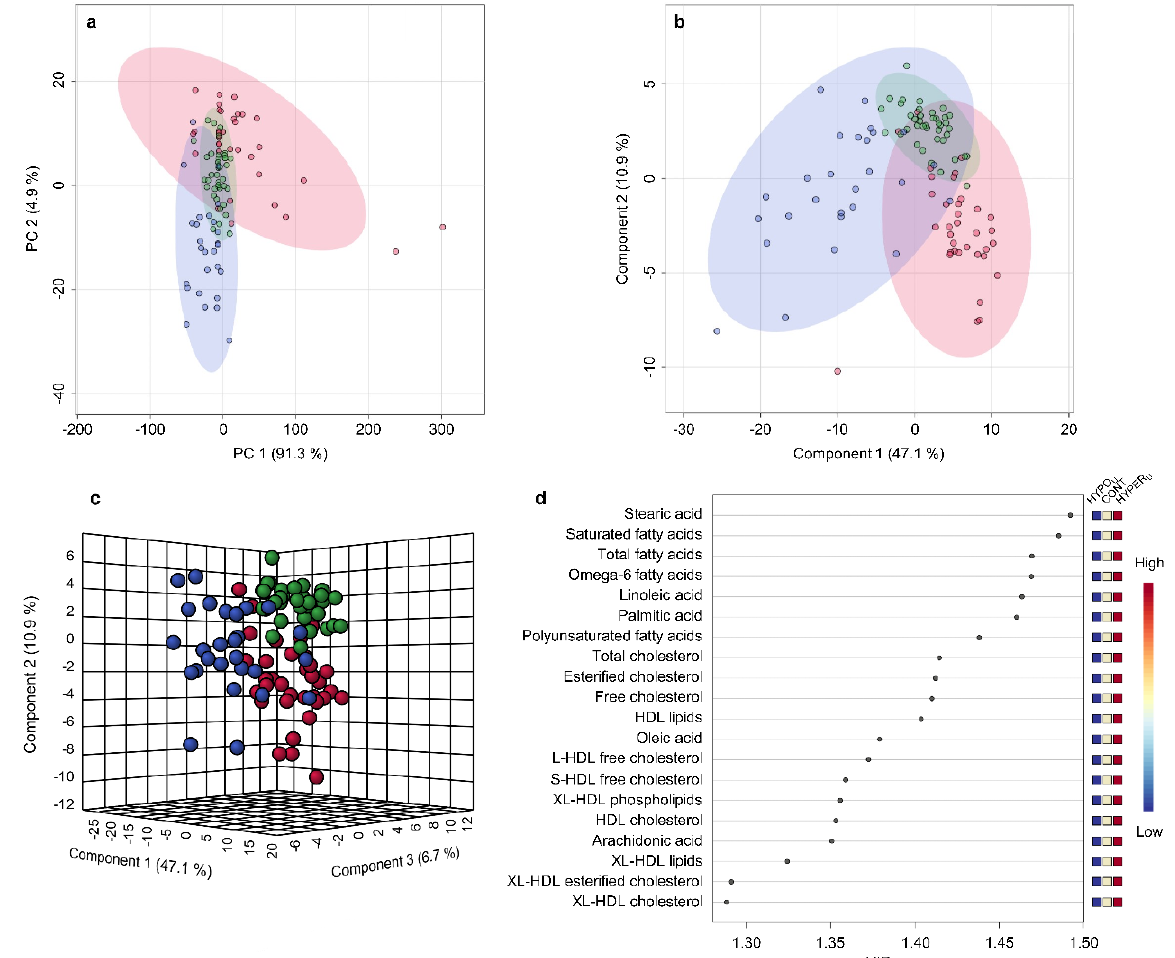
Figure 1. Metabolomic analyses of serum samples from dogs in the groups of hyperadrenocorticism untreated (HYPER U , n = 27), hypoadrenocorticism untreated (HYPO U , n = 35), and the control group (CONT, n = 40). ( a ) Scores plots of principal component analysis (PCA) and ( b ) partial least squares – discriminant analysis (PLS-DA) based on metabolomics data of serum samples of dogs in HYPER U (blue), HYPO U (red), and CONT (green) groups. Shaded circles represent 95% confidence intervals, while colored dots illustrate individual samples. The axes are labeled by the first (principal) components with the percentages of variance of the data explained by that component in parentheses. ( c ) The 3D scores plot of PLS-DA based on metabolomics data of serum samples of dogs in HYPER U (blue), HYPO U (red), and CONT (green) groups. ( d ) Variable importance in projection (VIP) scores of component 1 of the PLS-DA identifying the top 20 discriminating parameters in descending order of importance. The colored legend on the right indicates the relative abundance of the variables, with red and blue indicating high and low values, respectively, while beige illustrates neutral values.